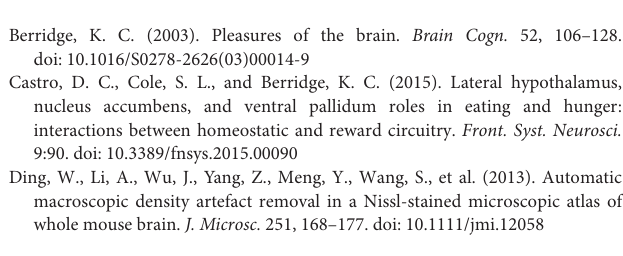
Supplementary Figure 1 | Schematics show the strategy of sparsely labeling neurons in the ventral pallidum (VP). (A) The paradigm of AAV vector infusions for sparse labeling of VP neurons. (B) The paradigm of AAV vector infusions for sparse labeling of VP neurons. Supplementary Figure 2 | Horizontal view of 41 fully reconstructed VP neurons. Supplementary Table 1 | Anatomical